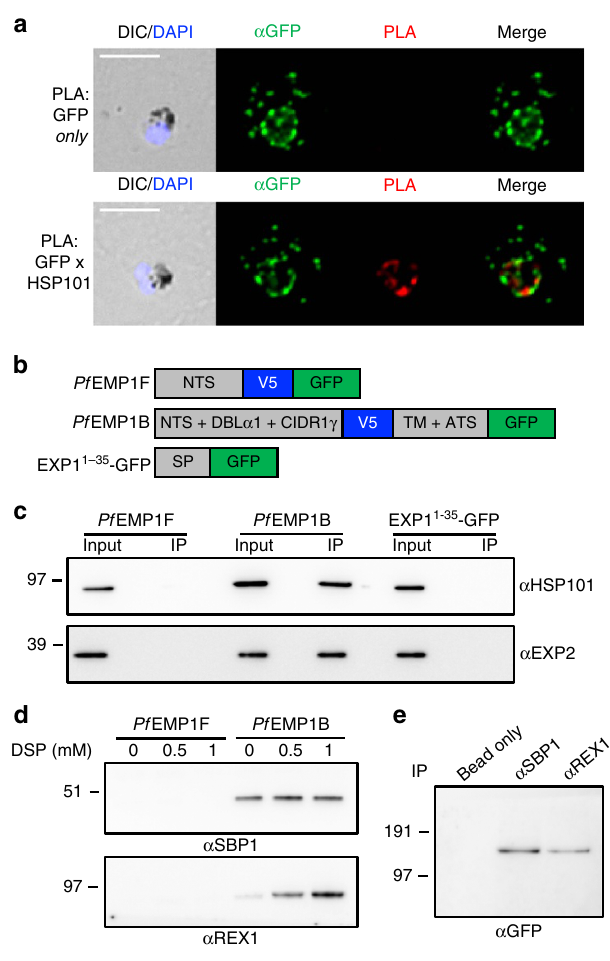
Figure 2 | Pf EMP1B interacts with components of PTEX and the Maurer’s clefts. ( a ) Proximity ligation analysis (PLA) of Pf EMP1B-infected RBCs labelled with antisera recognizing GFP alone (top) or GFP and HSP101 (bottom). A PLA signal is only produced if the primary epitopes are r 40nm apart. DIC and DAPI (blue), anti-GFP (green) and PLA (red) are shown. Scale bars, 5 m m. ( b ) Schematic of GFP-fusion proteins used in immunoprecipitation (IP) experiments. Pf EMP1F contains the N-terminal sequence (NTS) from IT var 3 followed by a V5 epitope tag and GFP and is located in the parasite cytoplasm as previously described 16 . Pf EMP1B is as described in Fig. 1a. EXP1 1-35 -GFP contains the signal peptide (SP) from EXP1 followed by GFP and localizes to the PV as previously described 47 . ( c ) Immunoprecipitation of Pf EMP1F, Pf EMP1B and EXP1 1-35 -GFP transfectants using GFP-Trap. Total protein (input) and eluate (IP) were